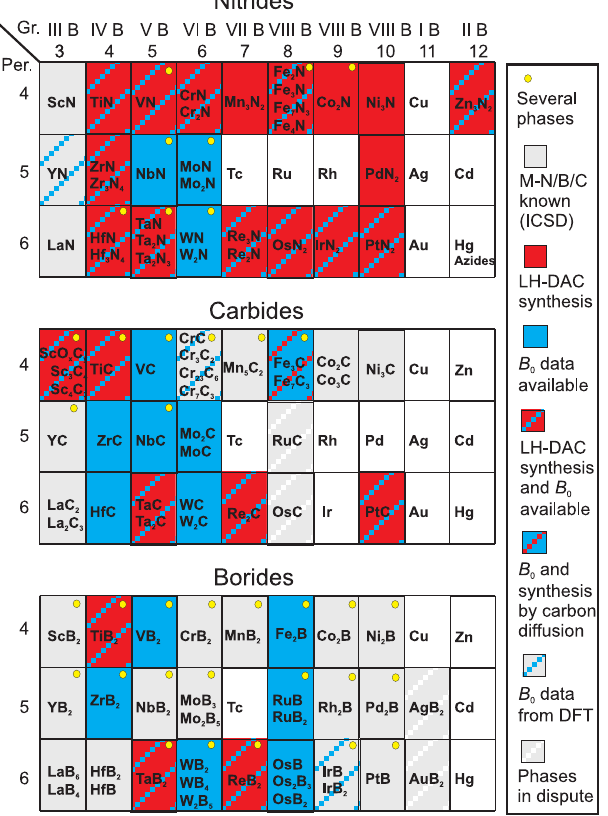
Figure 1. Overview of known binary transition metal nitrides, carbides, and borides discussed